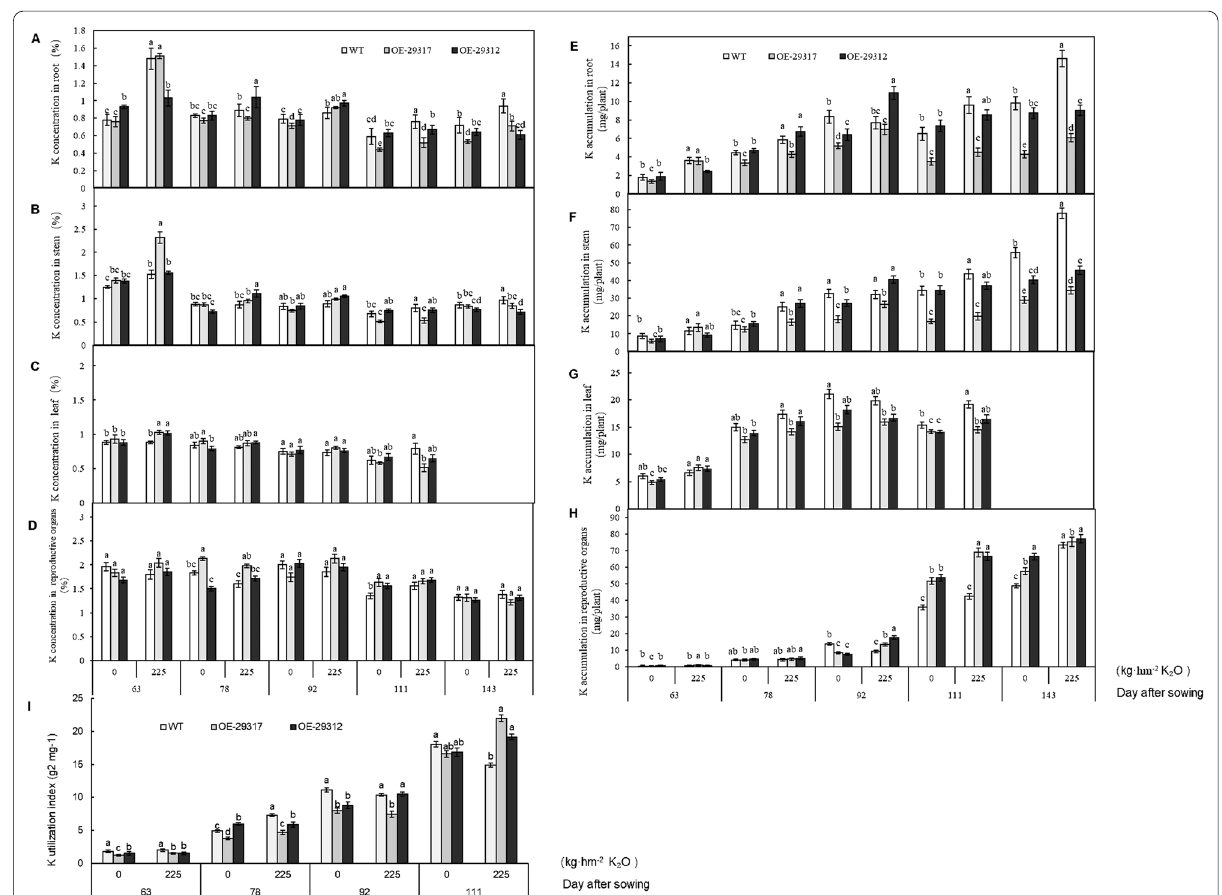
Fig. 2 Effects of Bacillus thuringiensis ( Bt ) genes on potassium (K) concentration ( A – D ), accumulation ( E – G ) and utilization index (I, the dry matter produced per unit K concentration at the plant level) in roots ( A , E ), stems ( B , F ), leaves ( C , G ) and reproductive parts ( D , H , including squares, flowers, and bolls) of cotton plants in the field. The available K + in soil was 47.8 mg kg − 1 . DAS: days after sowing. WT: wild type (Jihe 321); OE-29317 · and OE-29312: transgenic Bt lines. Bars with different letters indicate significant differences within the same day ( P < 0.05). Error bars depict standard errors of the